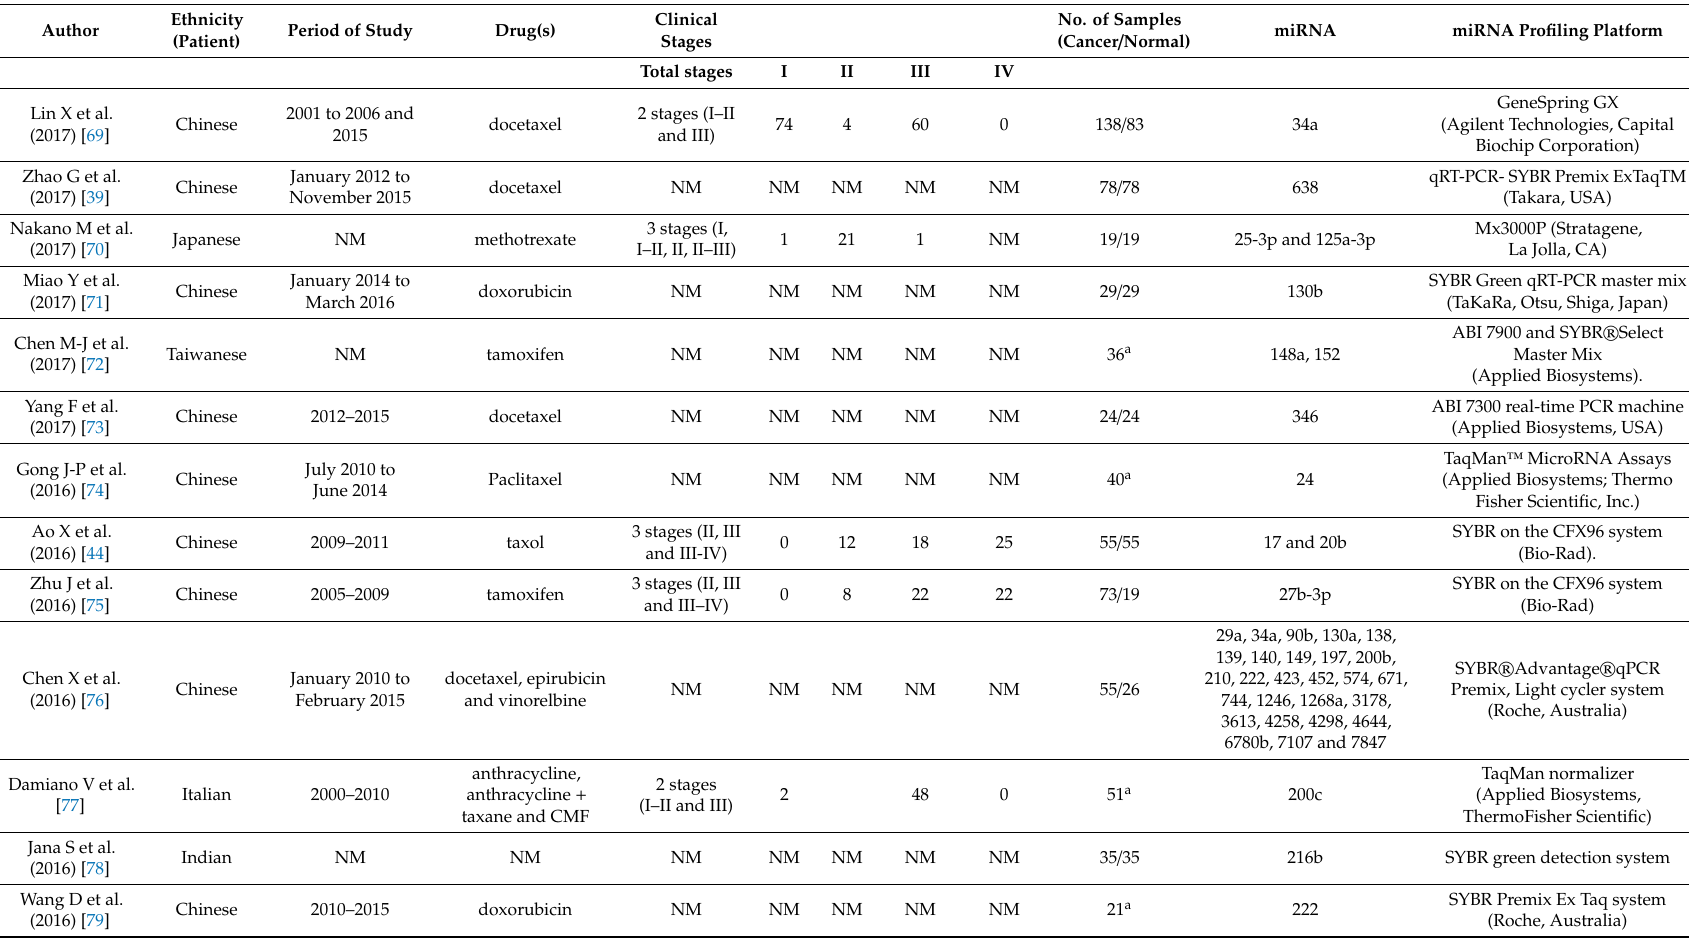
Table 1. Main characteristics of the included